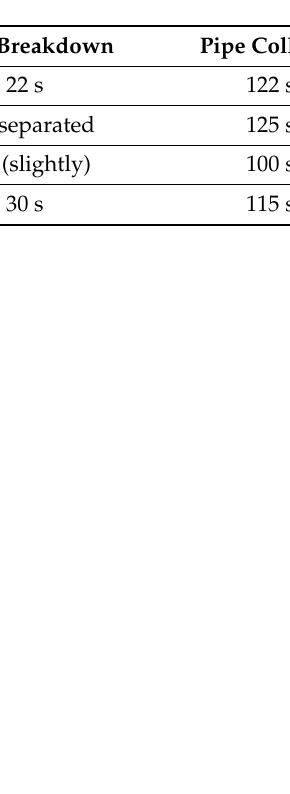
Table 2. Critical time points in T1–T4 TEBTs.